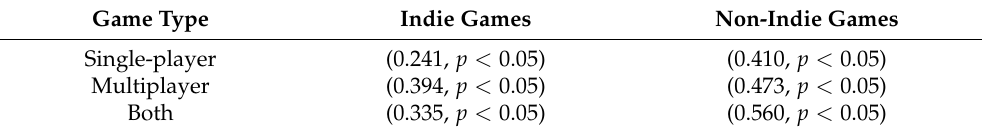
Table 5. Correlation between number of achievements and game ratings.